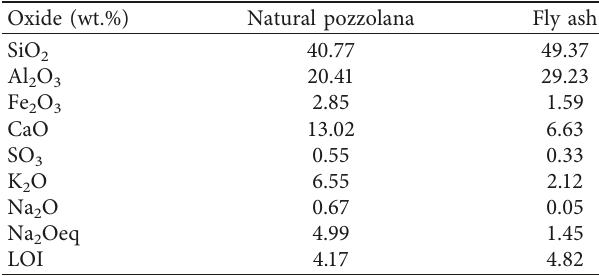
Table 2: Chemical compositions of natural pozzolana and coal fly ash. Oxide